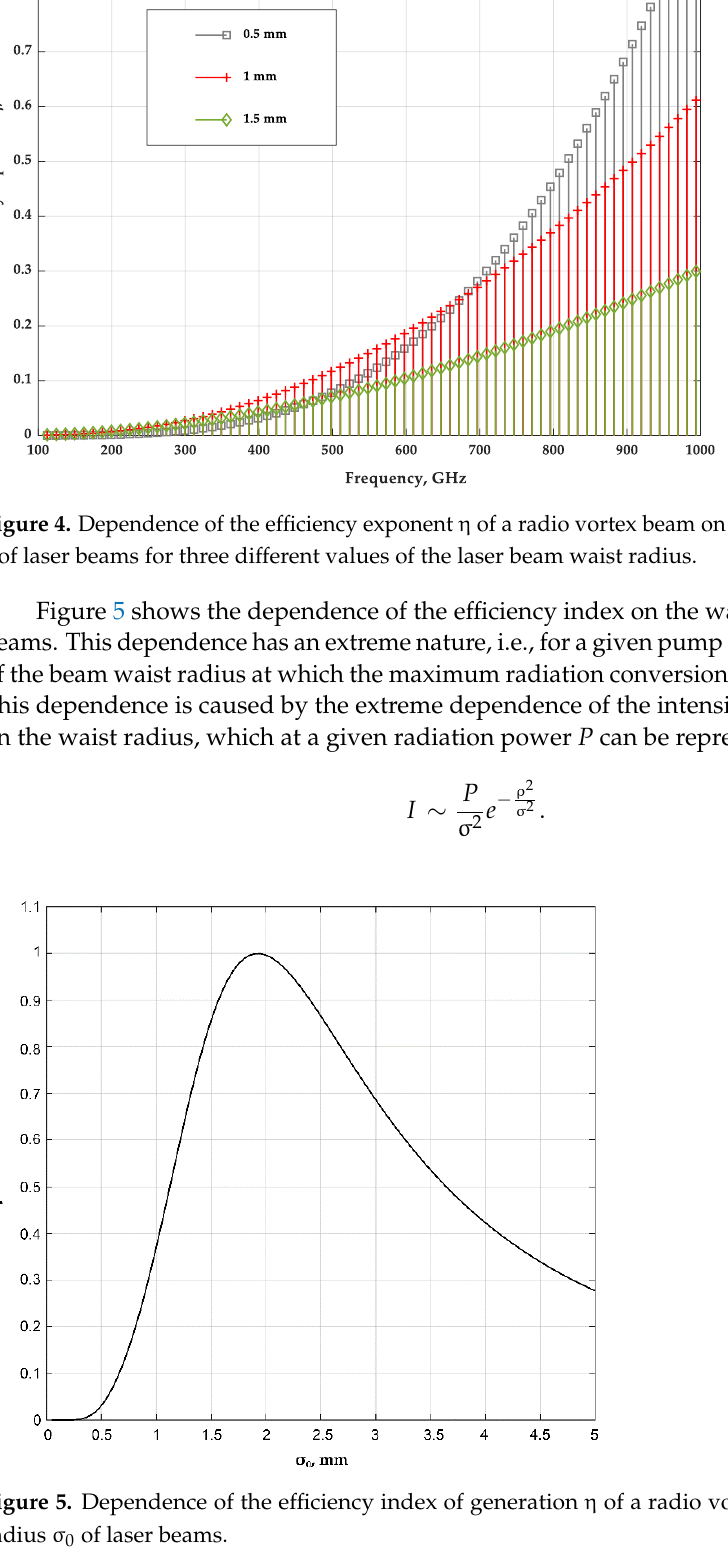
Figure 5. Dependence of the efficiency index of generation η of a radio vortex beam on the waist radius σ 0 of laser beams.